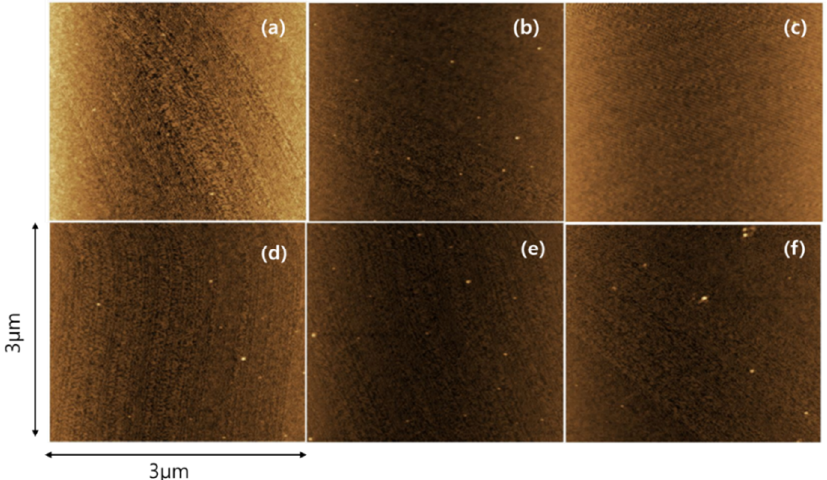
Figure 7. The 2D AFM images of the as-implanted and annealed samples. ( a ) as-implanted sample; ( b ) 299; ( c ) 308; ( d ) 335; ( e ) 353 and ( f ) 394 W.